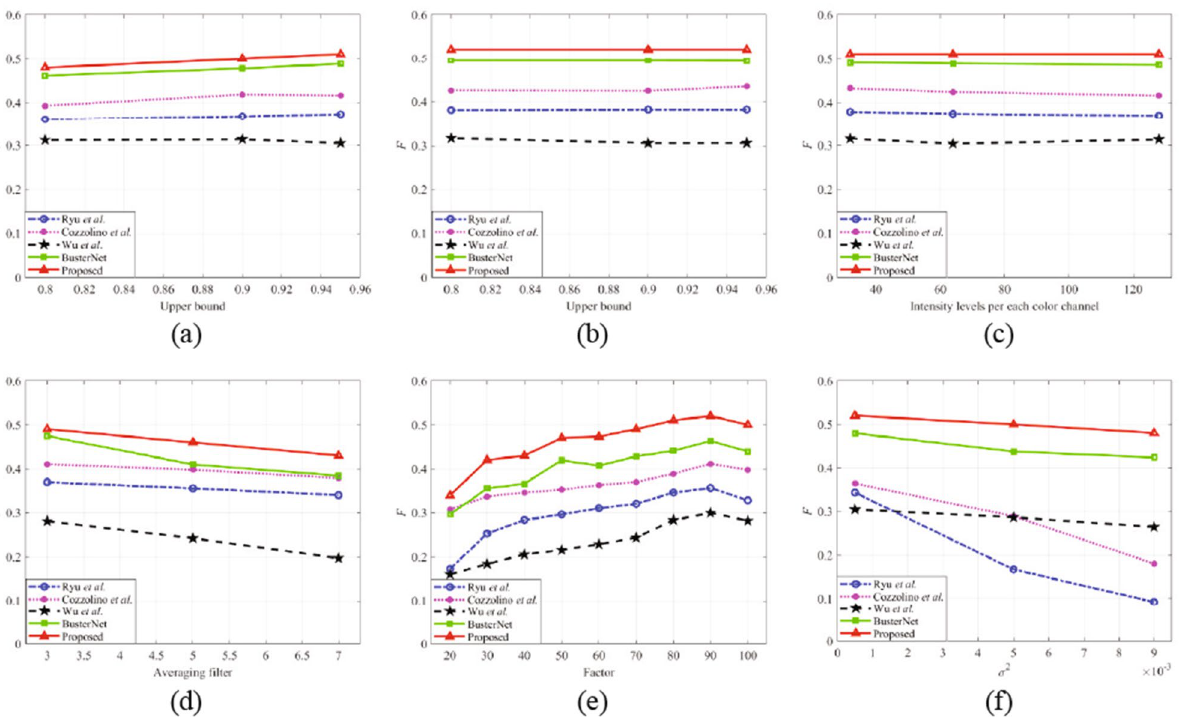
Figure 5. The F average of the SD-Net and other CMFD methods under six post-processing: ( a ) brightness change, ( b ) contrast adjustments, ( c ) color reduction, ( d ) image blurring, ( e ) JPEG compression, and ( f ) noise adding.